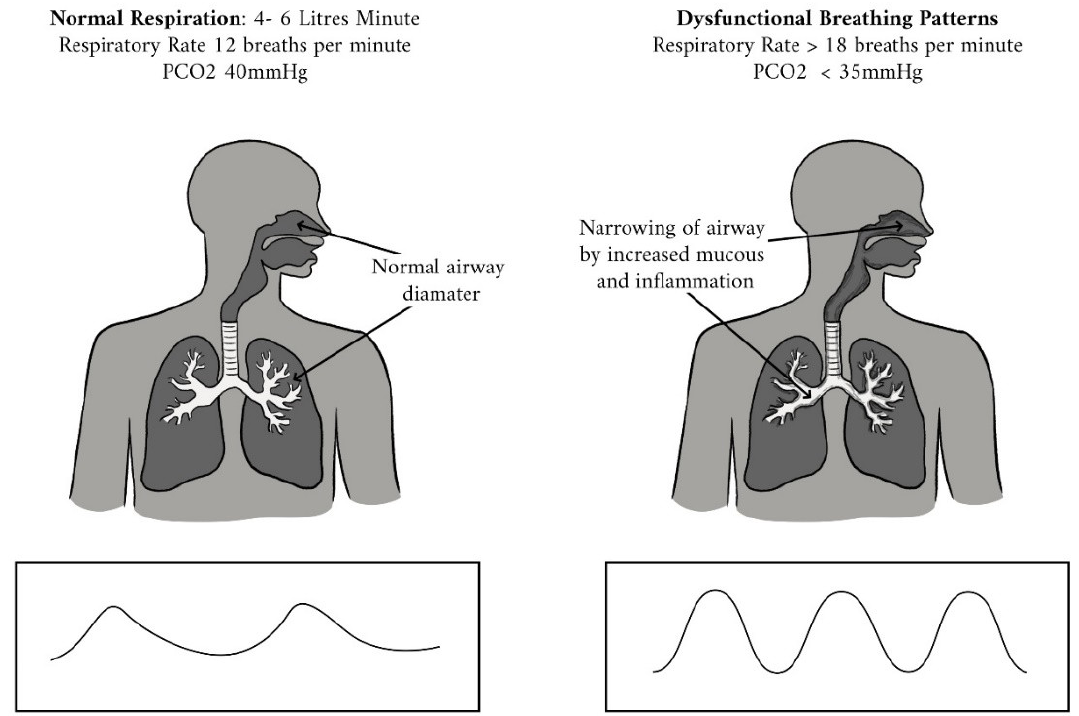
Figure 5. Normal breathing versus hyperventilation. Modified from www.RespiracionNormal.org [154].